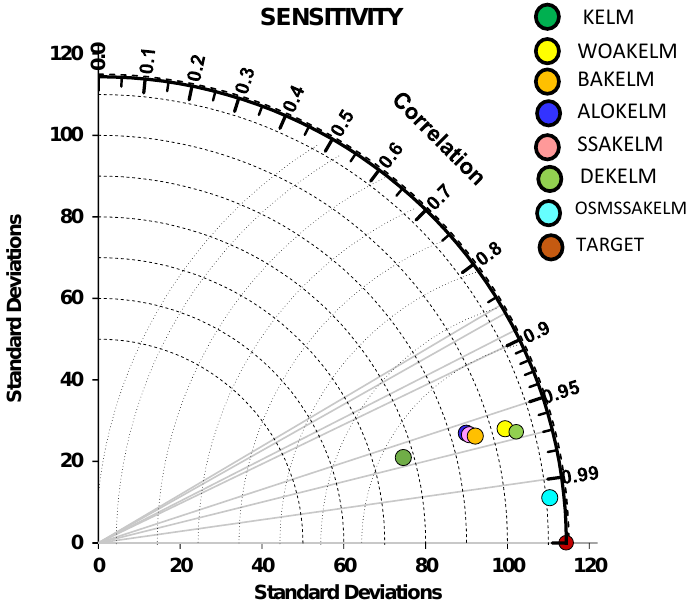
Figure 16. Taylor plot of optimized KELM models for the testing